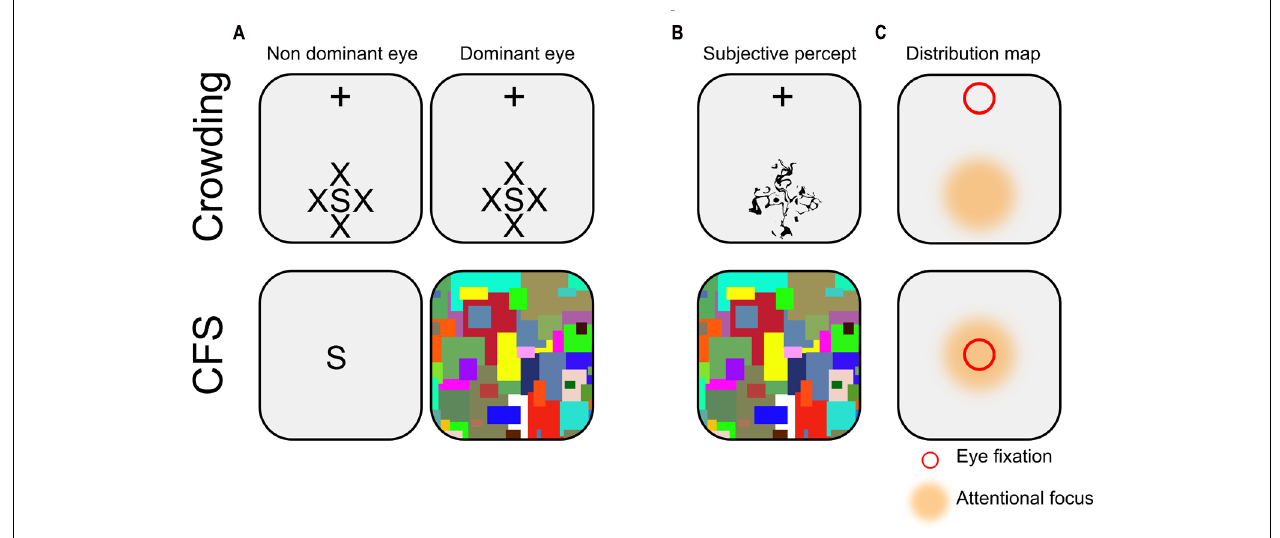
mondrians. (B) Subjective percept. In crowding, observers report seeing a jumbled array of letters in the periphery (i.e., discrimination, but not detection is impeded). In CFS, observers typically report seeing only the mondrians (i.e., both discrimination and detection are impeded). (C) Distribution map. In crowding, eye fixation (depicted here by a red square) and attentional focus (depicted here by an orange area) are always dissociated (i.e., endogenous attention), while they are usually conjoint in